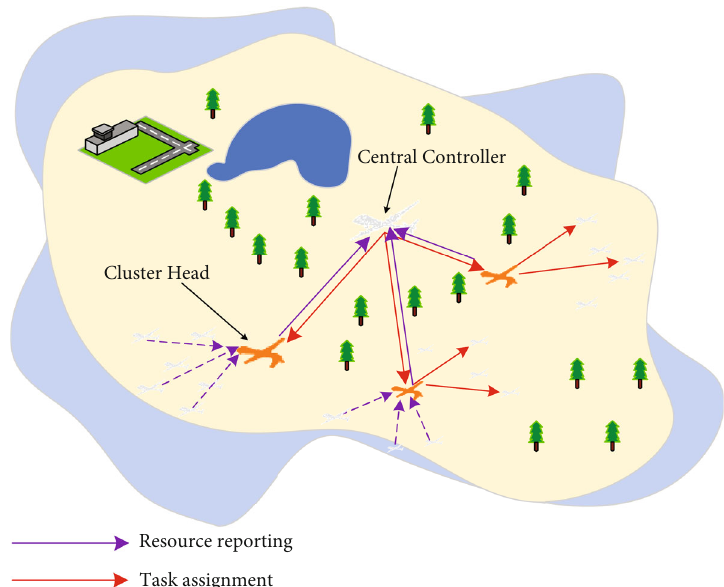
Figure 1: The multilayer task scheduling model of UAV swarm.